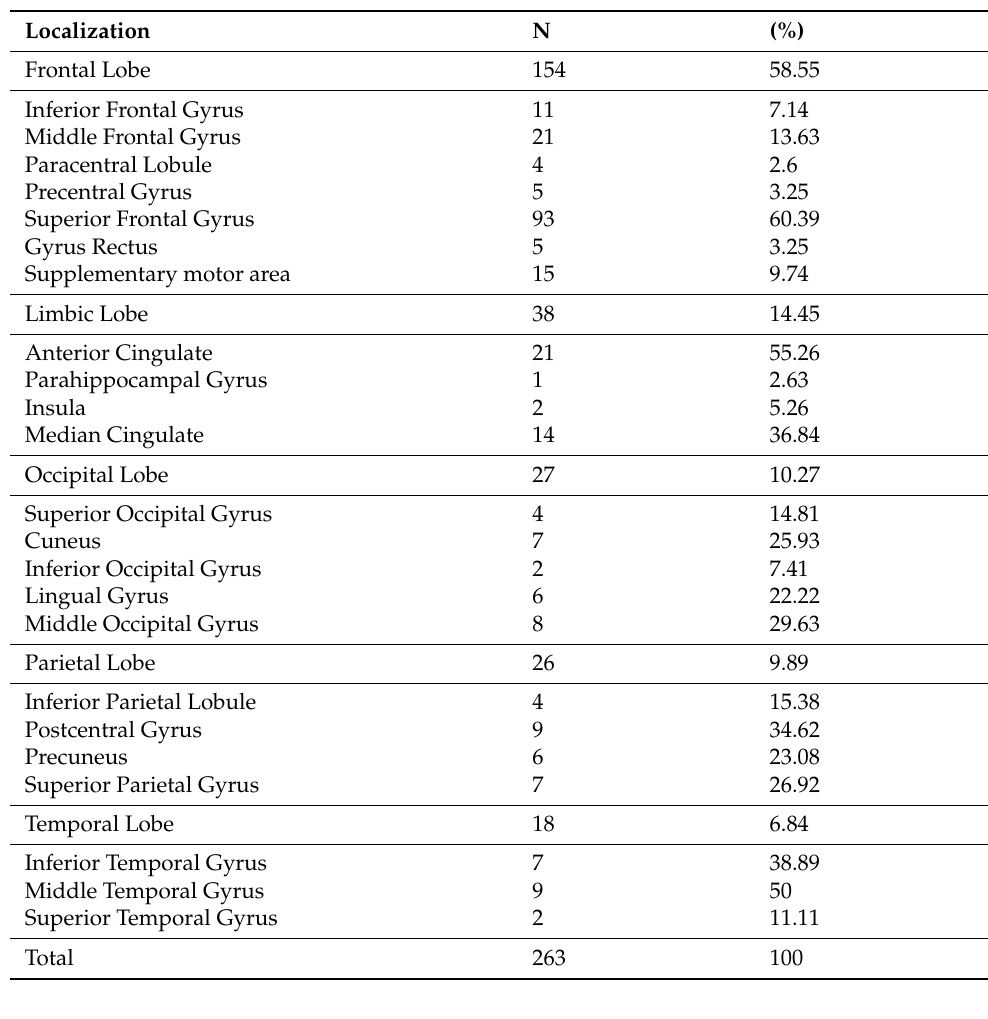
Table 2. Source localization of